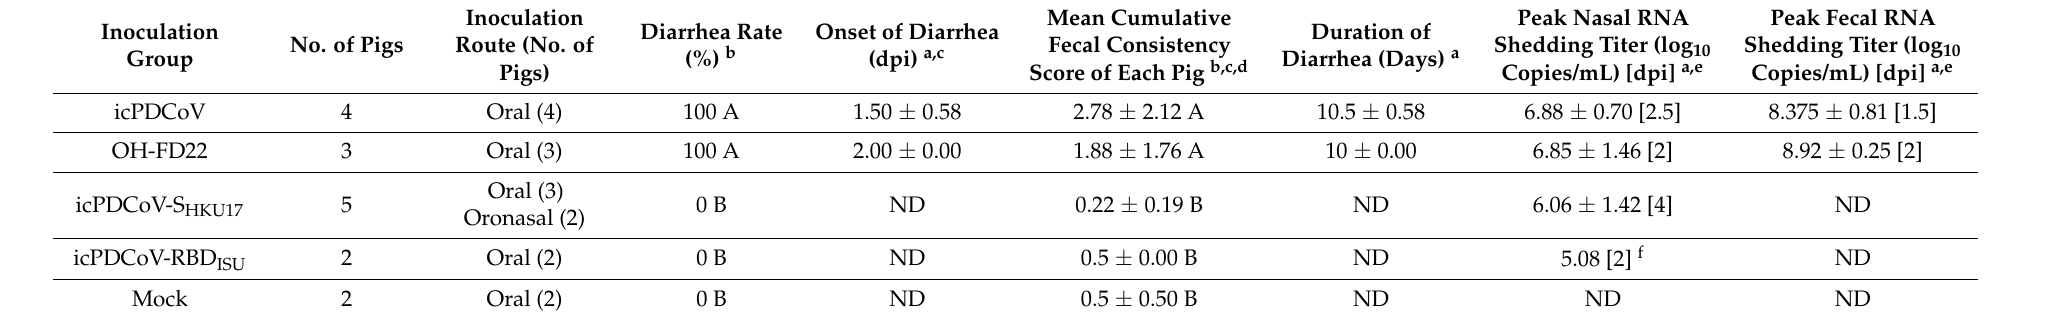
Table 1. General litter information and clinical signs of piglets after